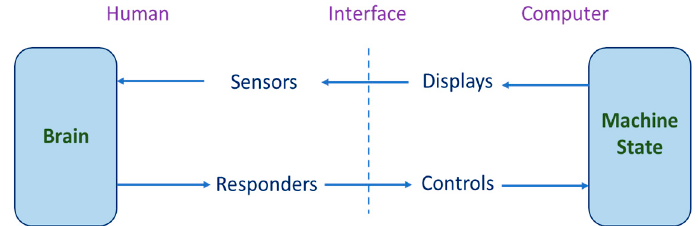
Figure 2. The human-factor view of a human operator in a human-computer interfacing working environment